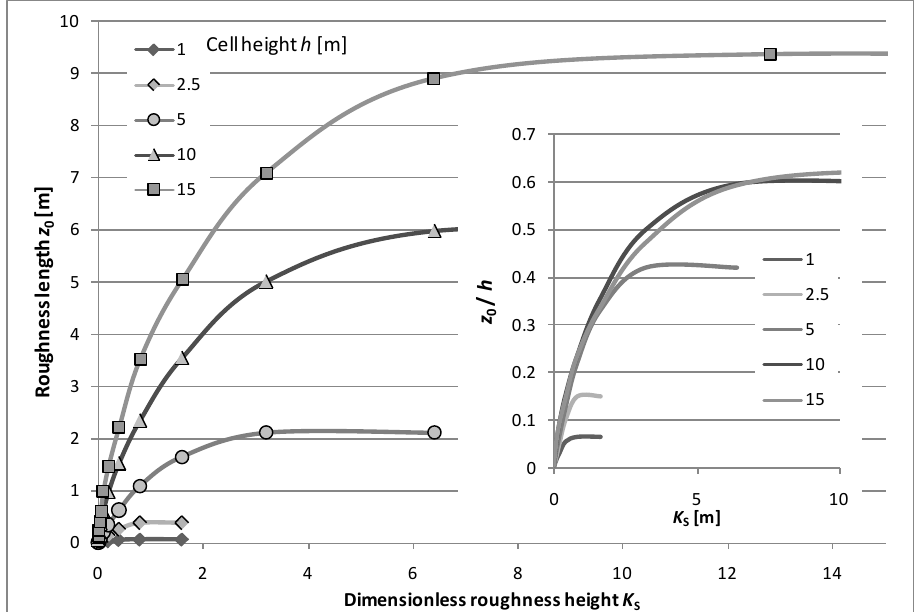
Figure 22. Relation between roughness length z K for different heights of the grid cell adjacent to the surface. Inset : Roughness length s normalized by the cell